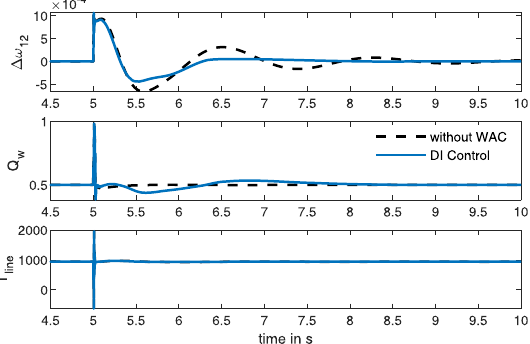
Fig. 5 a Relative rotor speed deviations; b Reactive power; c Tie-line power deviations for a three-phase fault with a fault resistance of 1 Ω